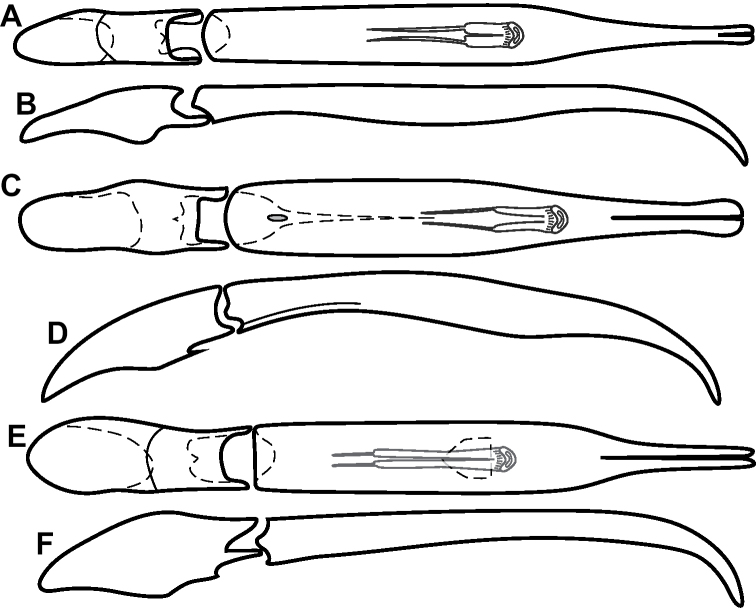
Male genitalia A, BPhelister
fraternus: A aedeagus, dorsal B aedeagus, lateral C, DP.
conjunctus: C aedeagus, dorsal D aedeagus, lateral E, FP.
striatinotum: E aedeagus, dorsal F aedeagus, lateral.